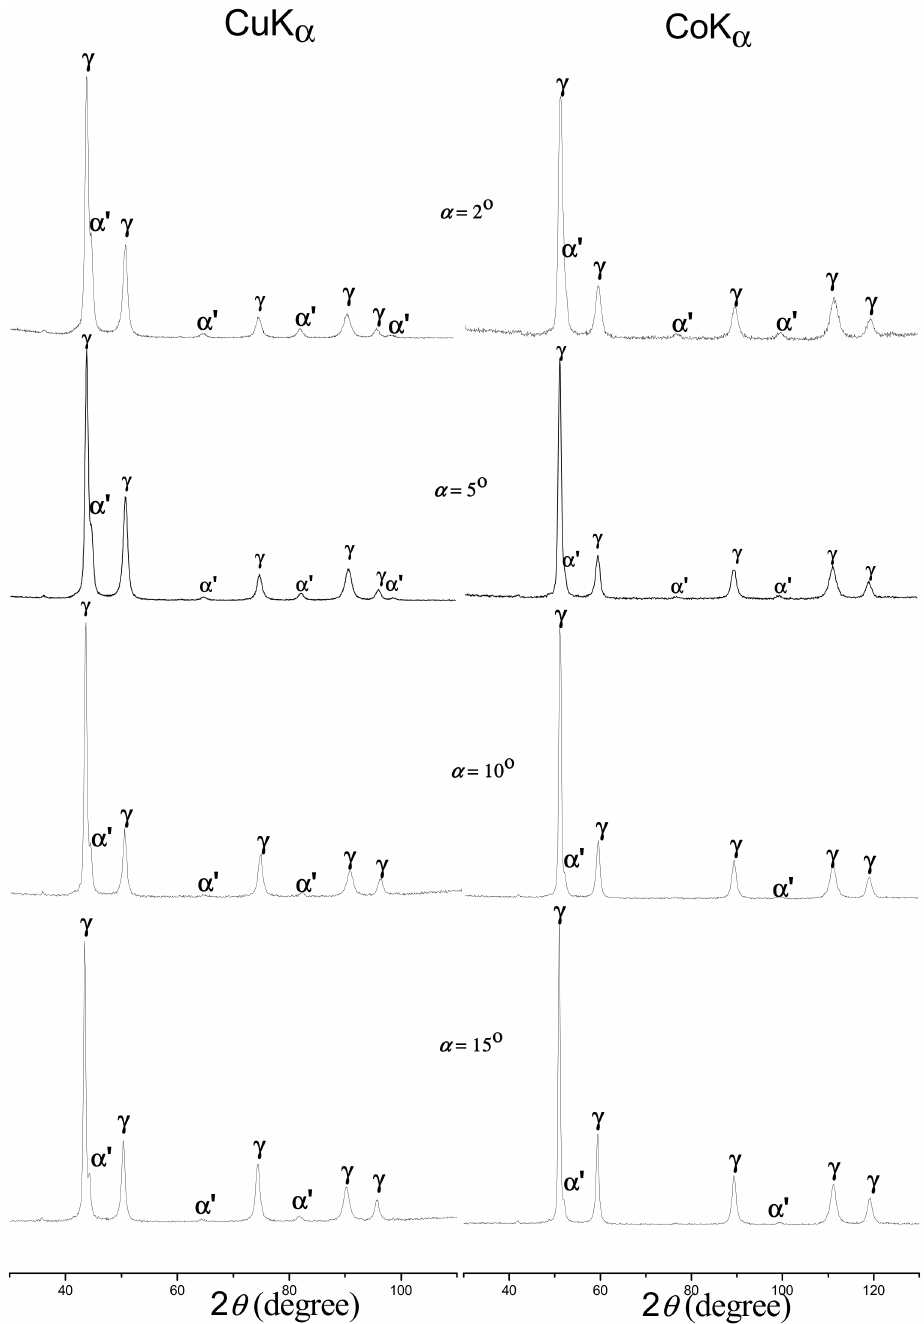
Figure 7. XRD patterns of Al-implanted AISI 321 steel obtained using CuK α and CoK α at various beam incident angles α